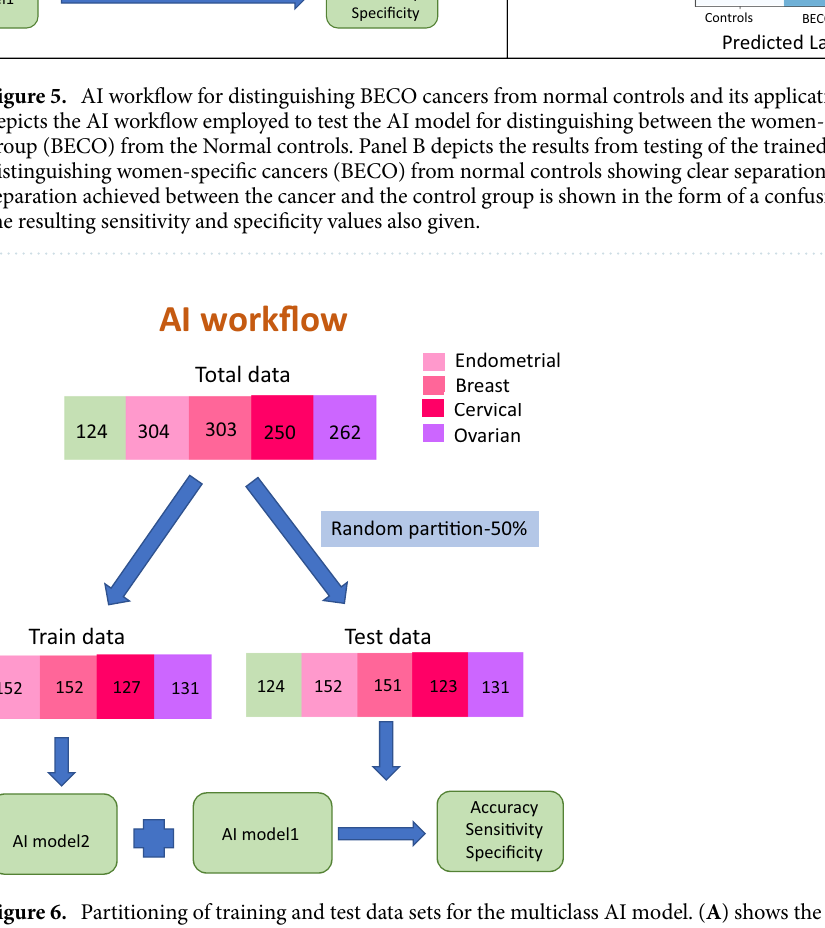
Figure 6. Partitioning of training and test data sets for the multiclass AI model. ( A ) shows the segregation of the individual cancer sets for training and testing of the multiclass AI model-2 (see text) for distinguishing between the individual cancers of the BECO